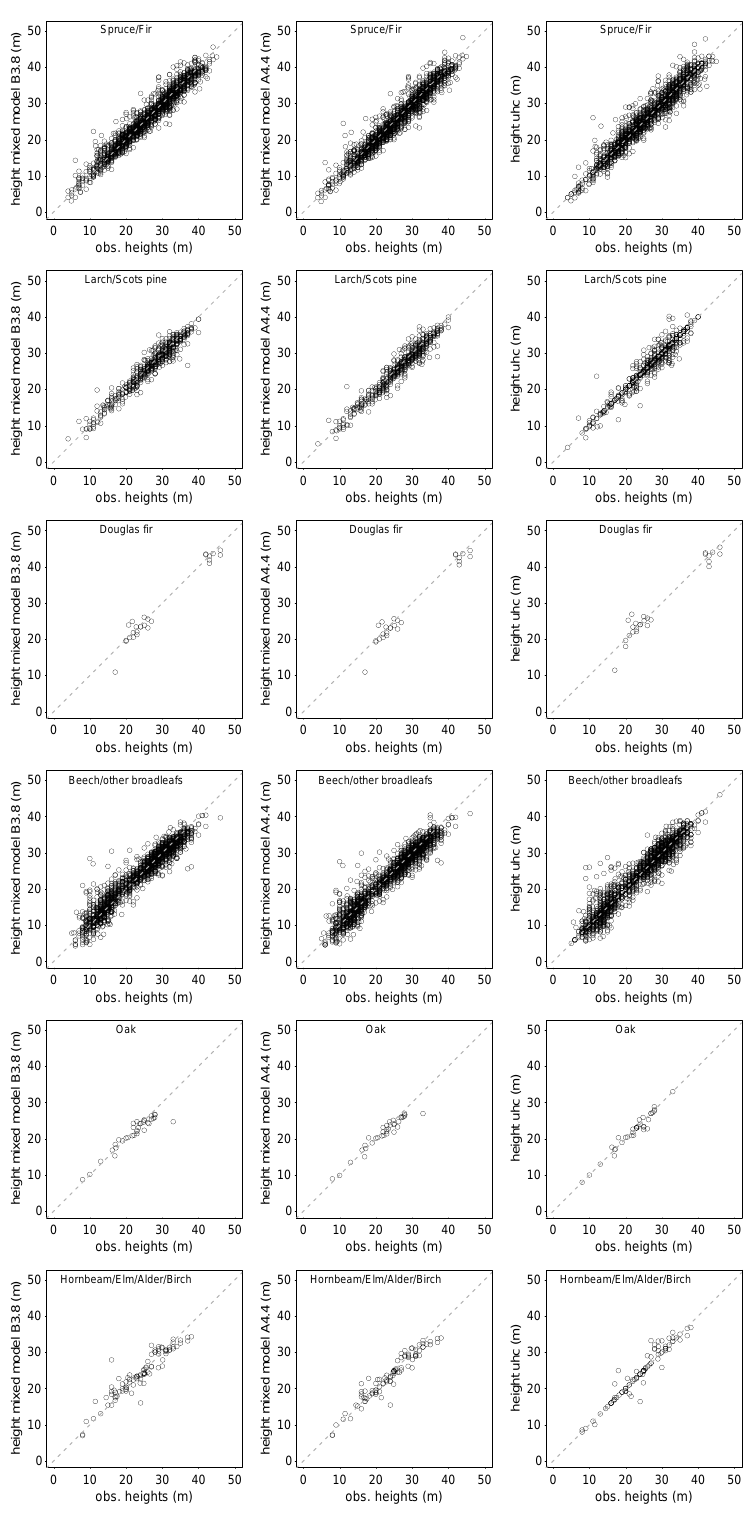
Figure A2. Predicted heights against observed heights.